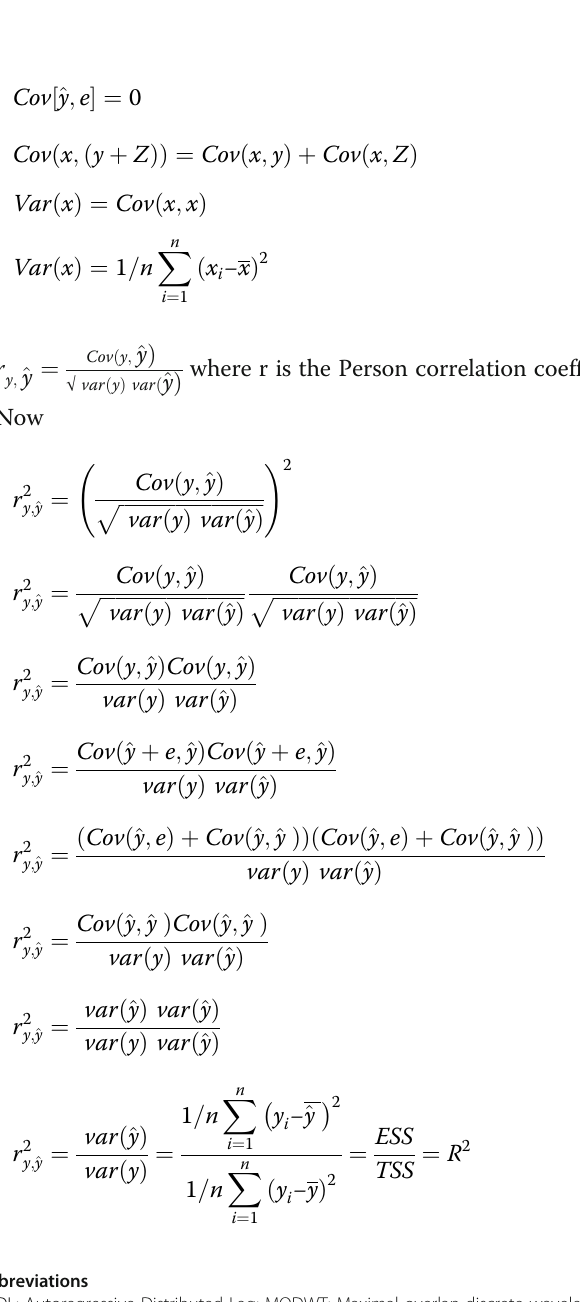
ffiffiffiffiffiffiffiffiffiffiffiffiffiffiffiffiffiffiffiffiffiffiffiffiffiffiffiffiffi p var y ð Þ var ^ y ð Þ